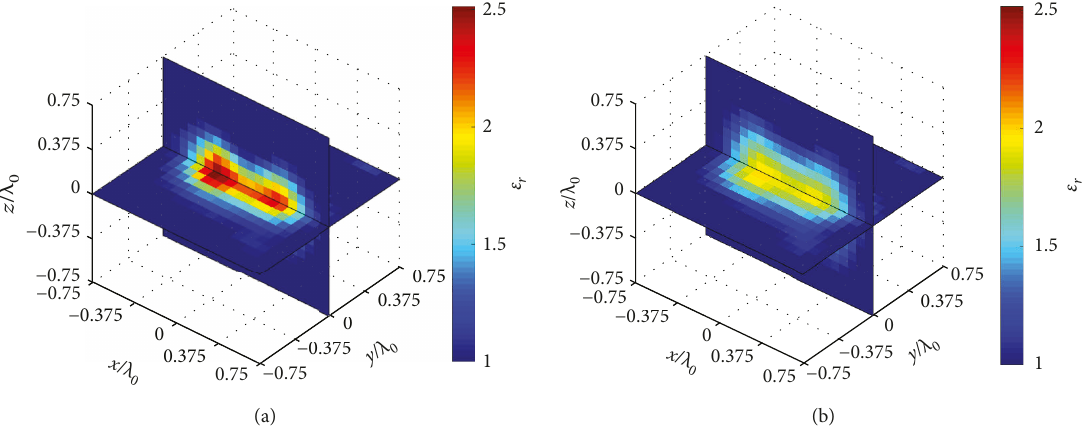
Figure 14: Reconstructed distributions of the relative dielectric permittivity with (a) p = p